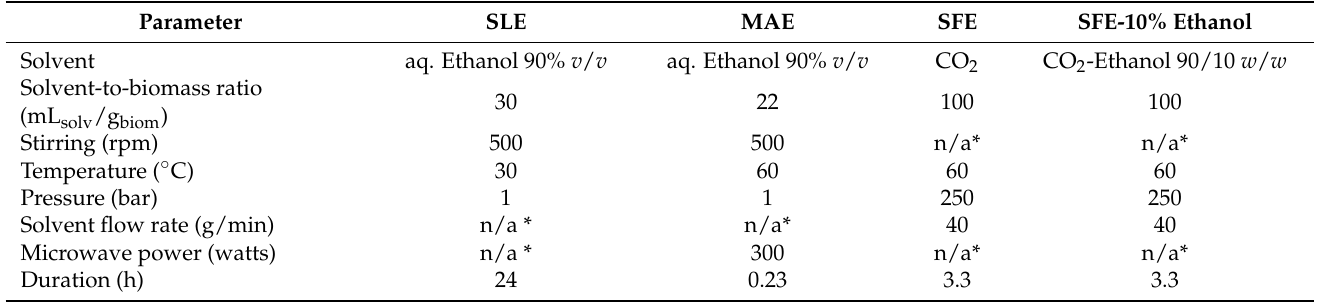
Table 4. The applied conditions of conventional solid-liquid extraction (SLE), microwave-assisted extraction (MAE), supercritical fluid extraction with CO 2 (SFE), and supercriticzal fluid extraction with CO 2 and cosolvent addition (SFE-10%